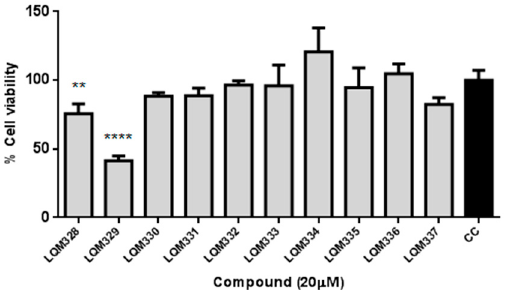
Figure 4. In vitro evaluation of cytotoxicity for synthesized acrylamides towards Vero E6 cells. The cytotoxicity was performed in vitro for ten synthesized acrylamides (LQM328 to LQM337) towards Vero E6 cells at 20 µ M concentration by MTT assay after 48 h. The expressed values are results from mean ± SD of triplicates at 20 µ M concentration, analyzed after 48 h. CC = cellular control. ** p ≤ 0.01; **** p ≤ 0.0001 versus CC.